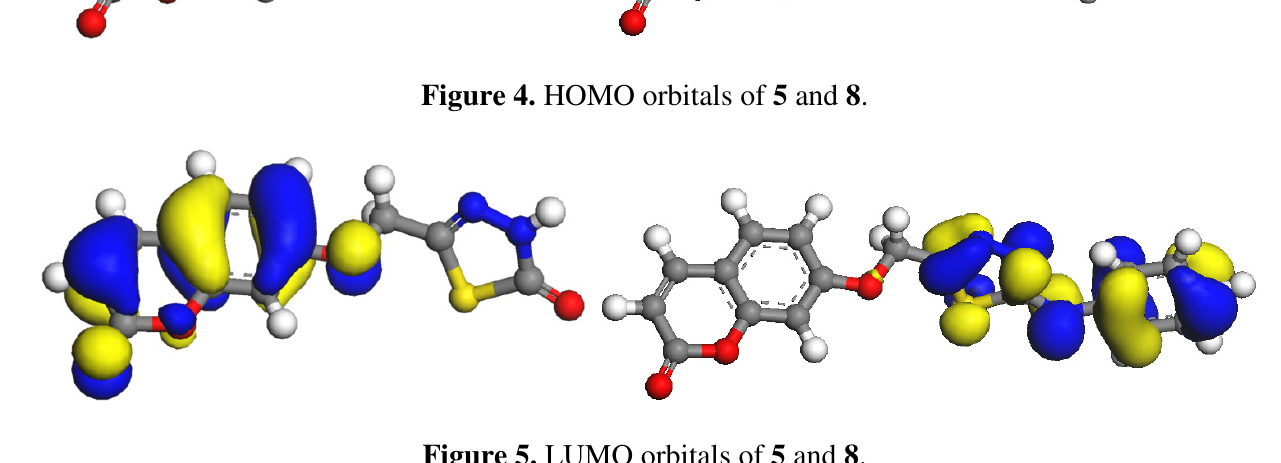
Figure 5. LUMO orbitals of 5 and 8